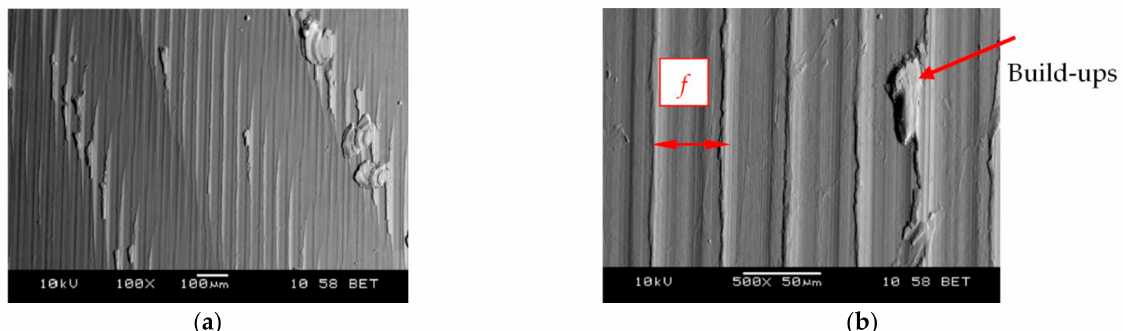
Figure 19. Microscopic image of the machined surface with visible deformations (build-ups); (sintered nickel-cobalt alloy, VB = 0.35 mm): ( a ) magnification 100 × , ( b ) magnification 500 × ; f —feed.